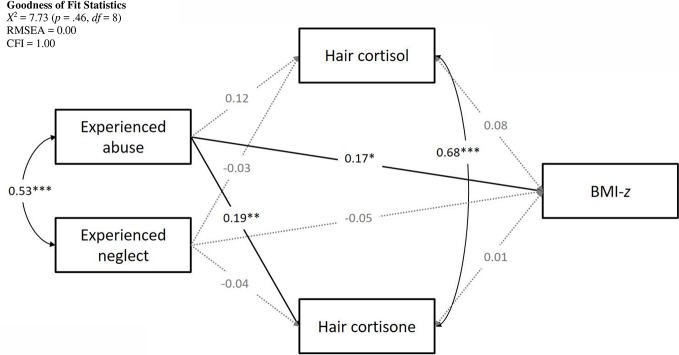
Structural model.